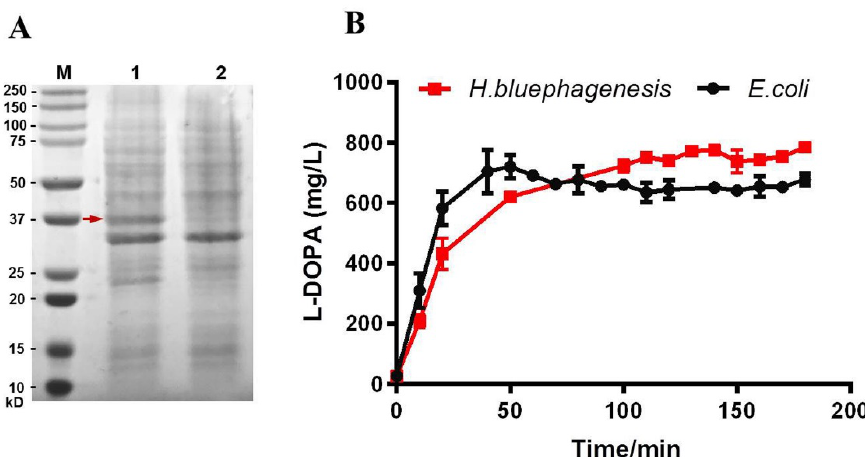
Figure 3. Expression of free TyrVs in H. bluephagenesis TD strain and L-DOPA productivity in recombinant H. bluephagenesis TD and E. coli harboring free TyrVs: ( A ) expression of free TyrVs in recombinant H. bluephagenesis TD (pMCS1-Vs) was confirmed by SDS-PAGE of whole-cell lysates. Lane 1, H. bluephagenesis TD (pMCS1-Vs), Lane 2, wild-type H. bluephagenesis TD, M, protein marker. The red arrow indicates the 37 kD band of free TyrVs; ( B ) L-DOPA production by the same volume of cell lysates of H. bluephagenesis and E. coli harboring free TyrVs. The error bars indicate the SD values from triplicate trials.